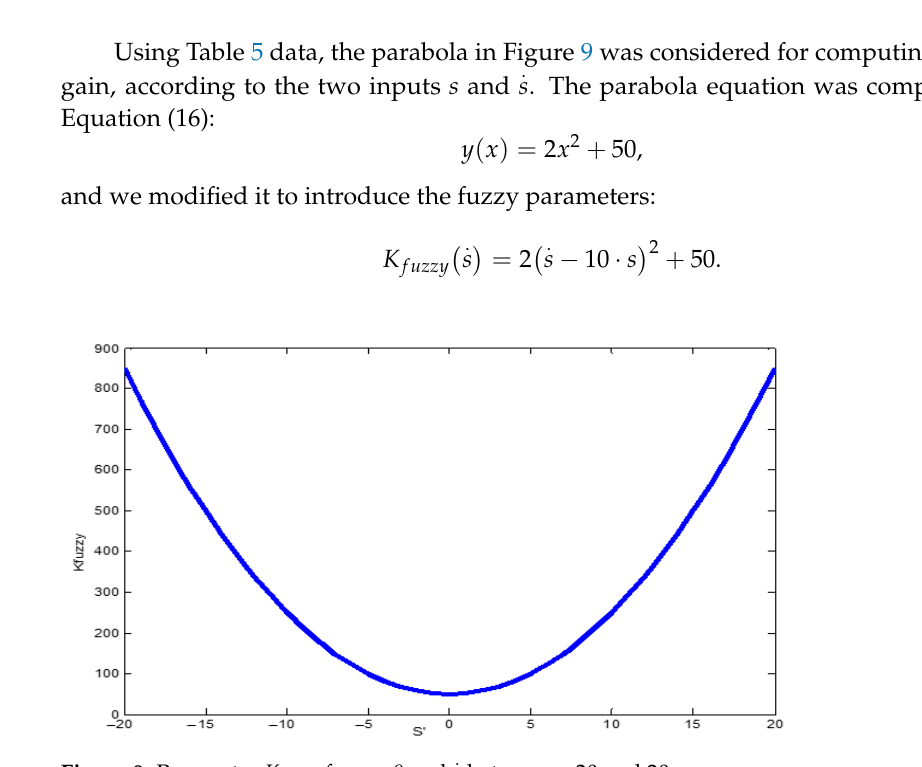
Figure 9. Parameter K fuzzy for s = 0 and 𝑠̇ between −20 and 20